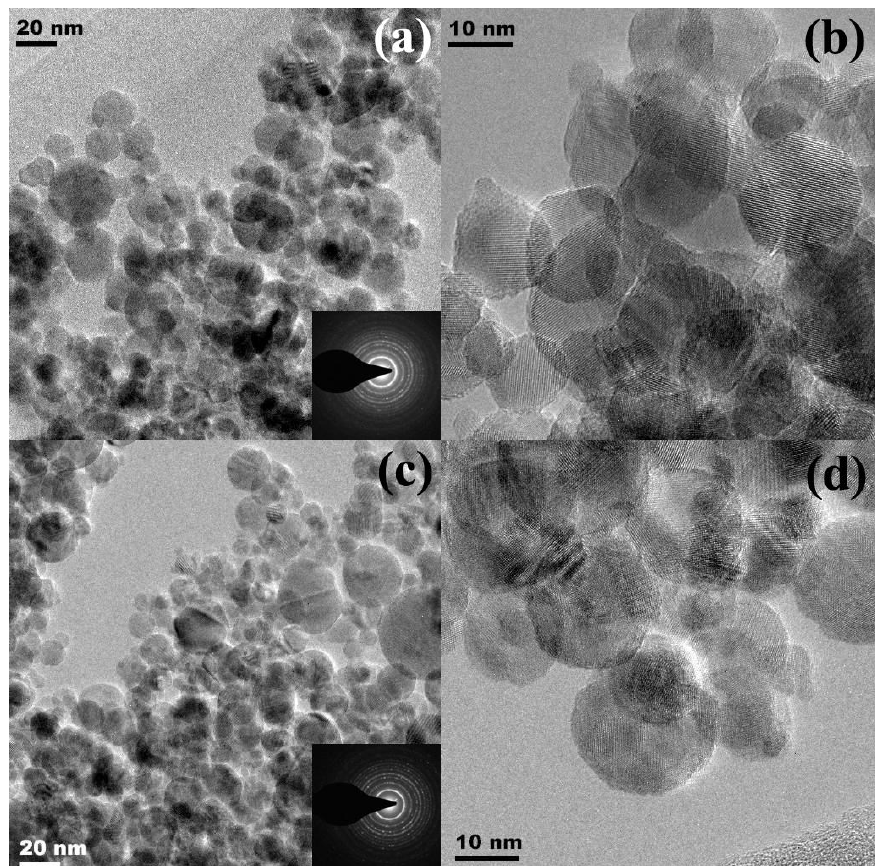
Figure 2. (a,b) HR-TEM bright-fields images of highly crystalline flame-made (5/5) TiO nanoparticles and (c,d) 5 at.% Nb/TiO show the corresponding diffraction patterns of the particles and clearly the TiO lattice